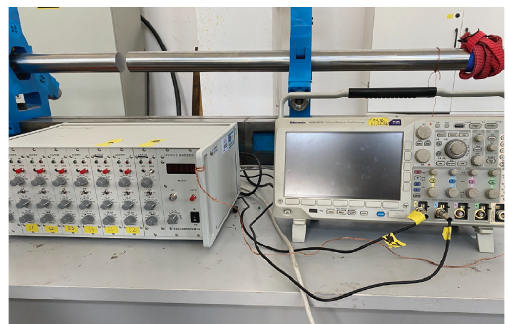
Figure 2: Ultra-dynamic strain gauge and